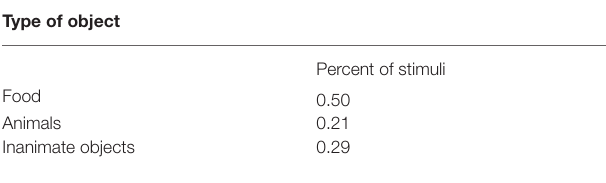
TABLE A1 | Distribution of stimuli included in this